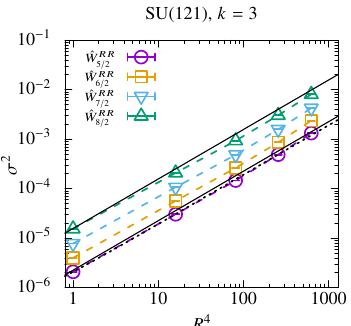
Figure 7. The loop size dependence of the variance (cid:27) 2 for ^ W RR k = 3). The dotted line shows the result of a (cid:12)t. Solid lines represent the ansatz eq. (3.1) with ‘ = 5 = 2 and 8 = 2.